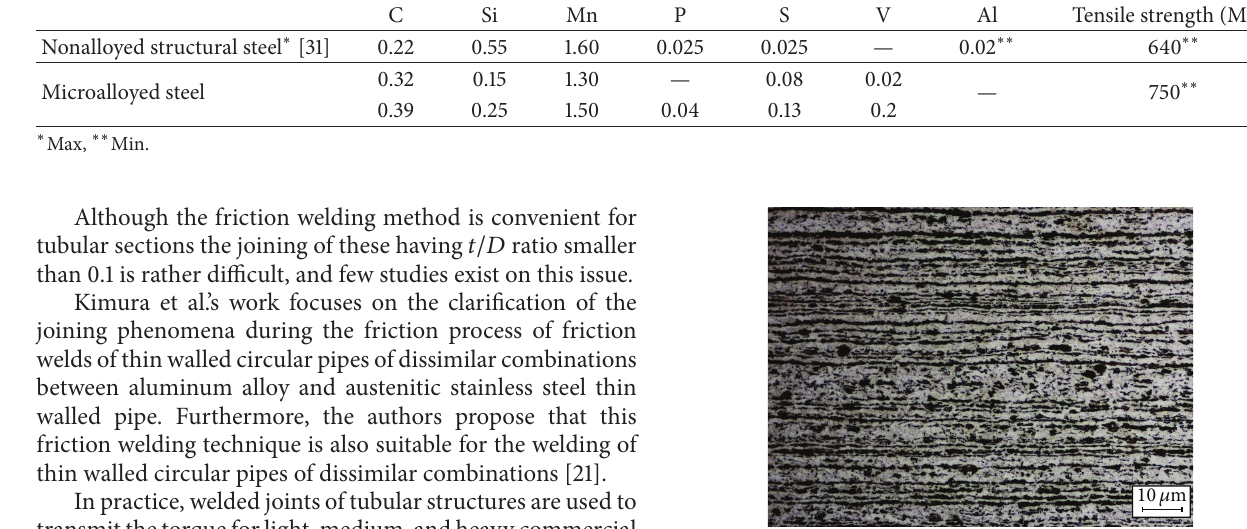
Figure 1: Microstructure of welded cold drawn nonalloyed struc- tural steel tube.